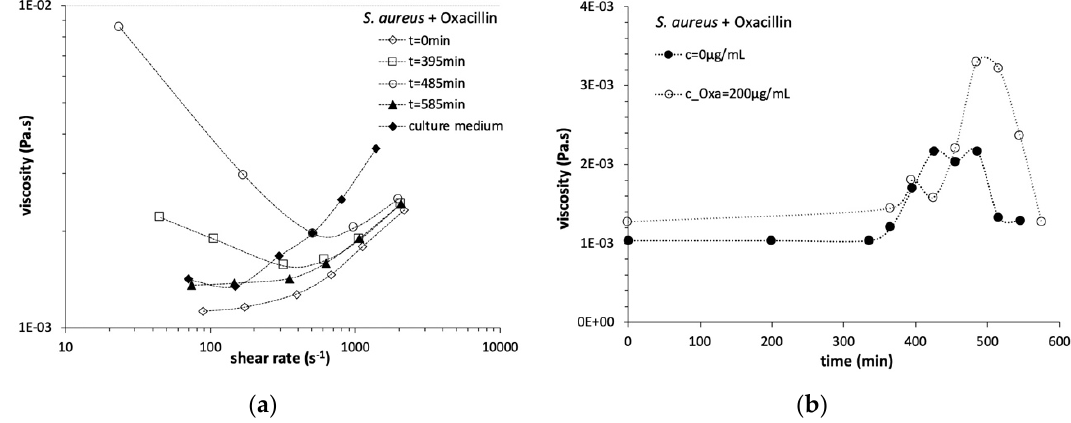
Figure 2. Steady-state shear flow characterization for bacterial cultures of S. aureus , with and without the addition of antibiotic during bacterial growth in the incubator at t = 350 min. Approach A: ( a ) flow curves of culture aliquots, removed from the incubator at specific time points during culture growth at: t = 0 min (open diamond symbol), t = 395 min (open square symbol), t = 485 min (open circle symbol), t = 585 min (full triangle symbol), culture medium (full black diamond symbol) and lines are guide to the eye. Similar behaviors were obtained for cultures without addition of oxacillin (representative curves). ( b ) Representation of shear viscosity values in function of time, obtained from the flow curves for the shear rate value of 100 s −1 : without antibiotic (full black symbol) and with oxacillin at c_Oxa = 200 µg/mL (full gray symbol). All measurements were performed at 20 °C to minimize cell growth during the assays.